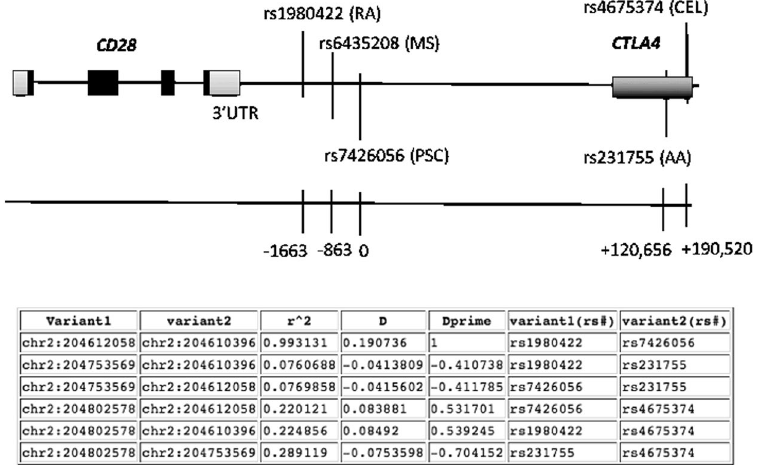
Figure 1. Location of rs7426056 single nucleotide polymorphism on CD28 locus. Rs7426056 SNP is located between CD28 and CTLA4 genes; approximately 3.5 kb downstream the CD28 3 ′ UTR and approximately 120 kb upstream CTLA4 gene. Several risk variants in the CD28/CTLA4 locus have been associated with other autoimmune and immune-mediated diseases. Exons are indicated in black. ( B ) Table shows the linkage disequilibrium of rs7426056 with the other SNPs in CD28 and CTLA4 genes. PSC: primary sclerosing cholangitis, RA: rheumatoid arthritis, MS: multiple sclerosis, AA: alopecia areata, CEL: celiac